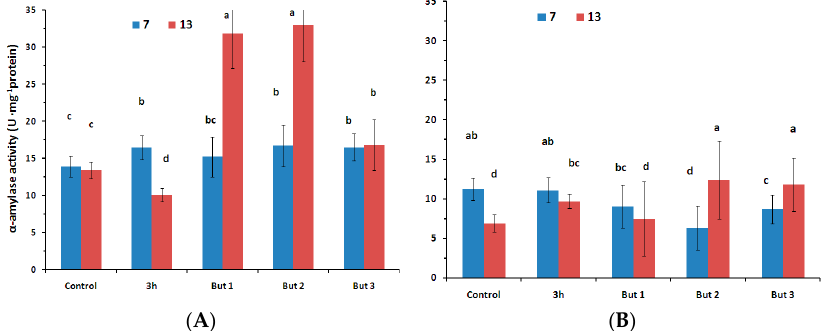
Figure 4. Activity of α -amylase [U·mg − 1 protein] in the seeds of two L. angustifolius cultivars (Lazur—( A ); and Sethes Fruehe Rote—( B )) germinating at 7 °C or 13 °C in water (control), butenolide or hydroprimed in water for 3 h at 20 °C. But 1, But 2, But 3: 10 − 6 M, 10 − 5 M, 10 − 4 M butenolide, respectively. Different letters over error bars (±SE; n = 3) indicate significant differences (Duncan’s multiple range test, p < 0.05).